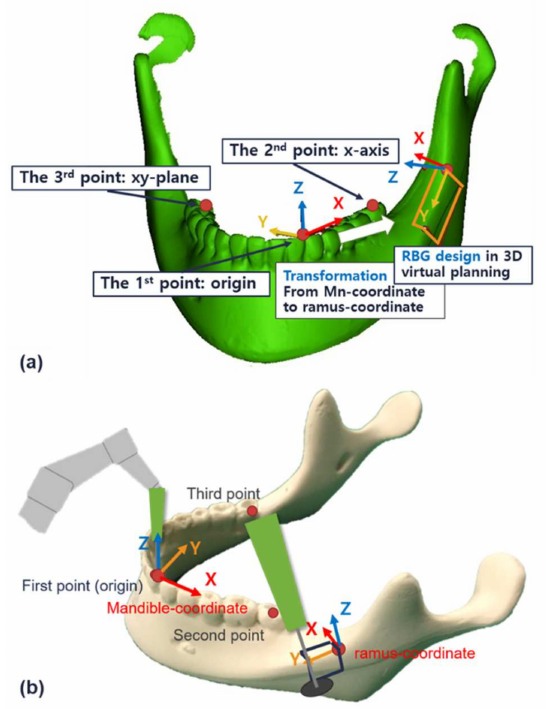
Figure 4. Schematic for the three-point coordinate determination and coordinate transform for the mandible phantom model. The ramal bone graft osteotomy was designed on the left ramus area ( a ). Schematics of the three-point coordinate determination and ramal bone graft osteotomy on the mandible phantom ( b